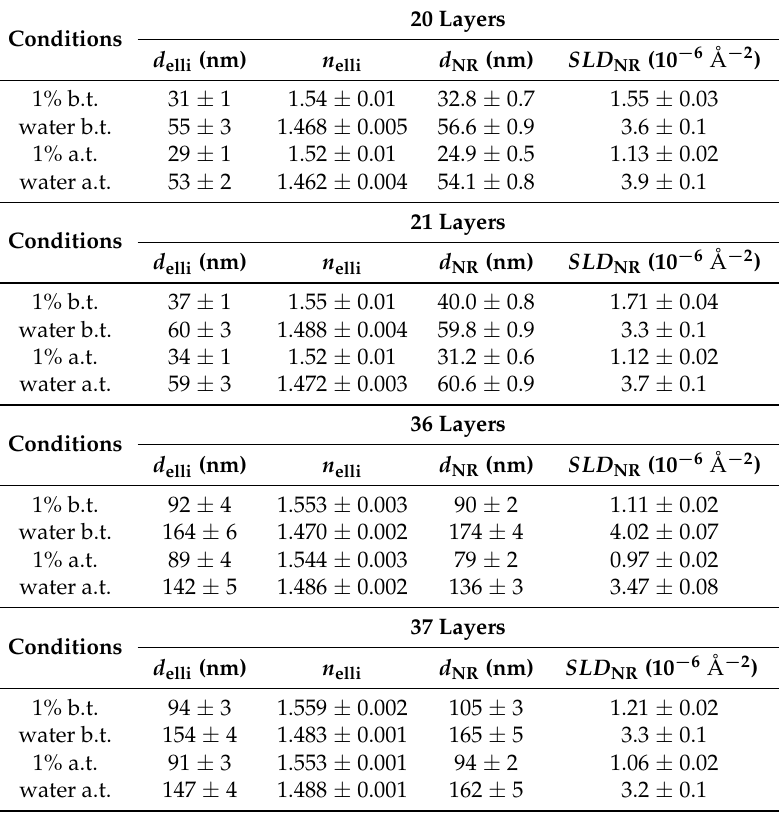
Table 1. Thickness ( d ), refractive index ( n ) and scattering length density (SLD) of the samples measured by ellipsometry and neutron reflectometry. The samples were measured in dried nitrogen (1% RH) and in water (H 2 O for ellipsometry and D 2 O for NR) before (b.t.) and after (a.t.) the temperature